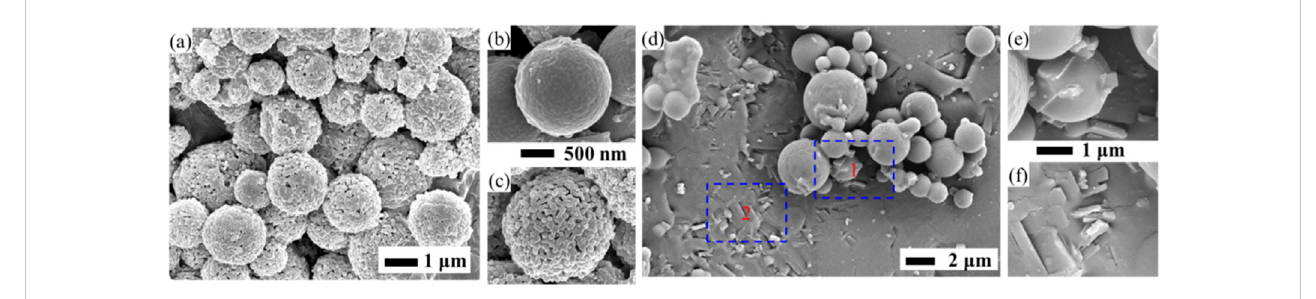
FIGURE 5 SEM images of 10-hydroxycamptothecin nanocrystals (HCPT NC)-zein particles after Na 2 CO 3 treatment (A) , magni fi ed images of HCPT NC-Zein particles before (B) and after (C) Na 2 CO 3 treating; HCPT NC-Zein particles partially dissolved with ethanol – water solution (D) , magni fi ed images of zone 1 (E) and 2 (F)